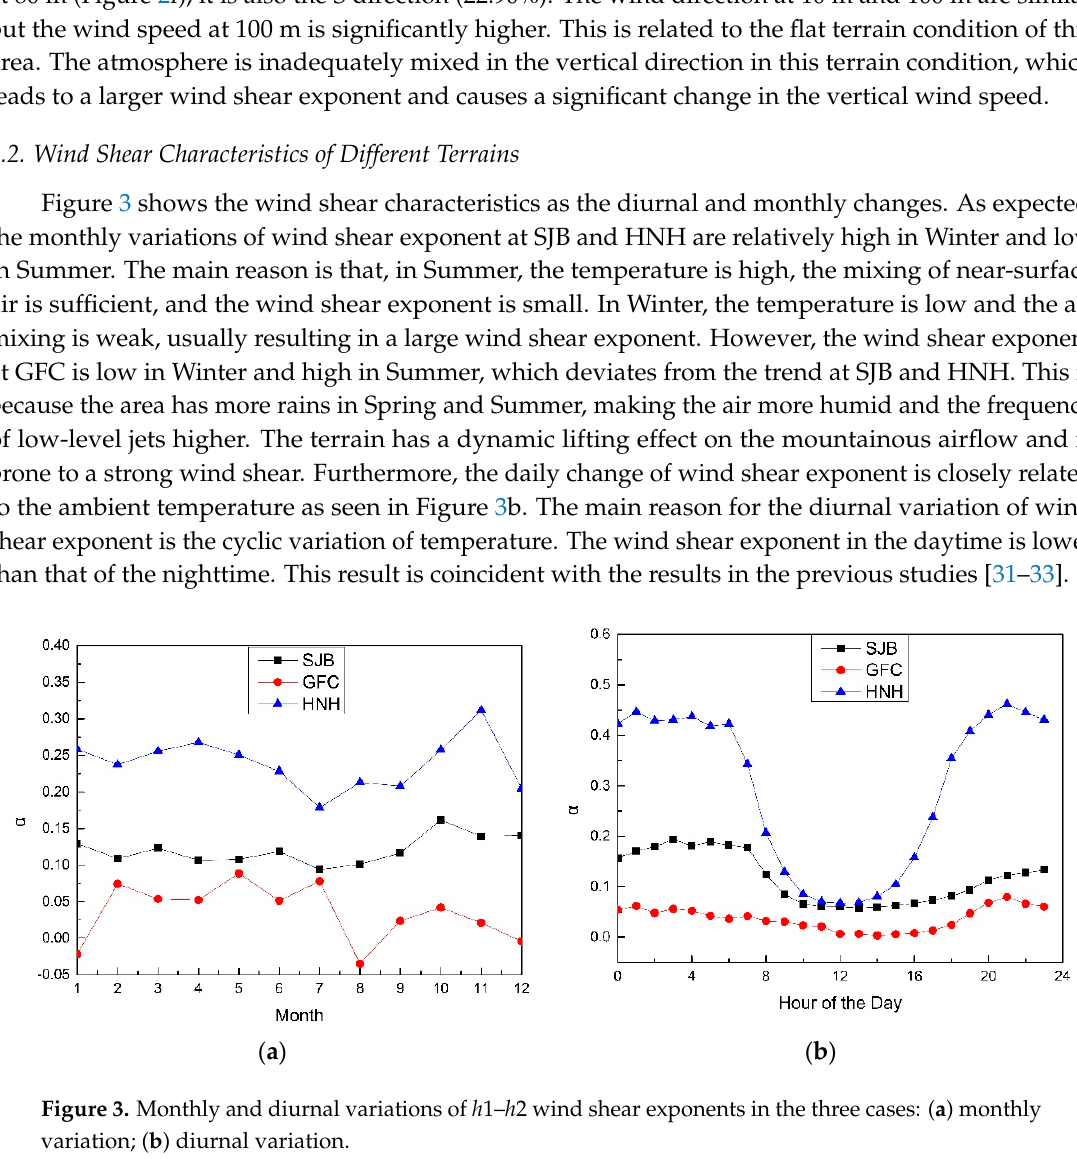
Figure 2. Wind rose measured at the three sites: ( a ) 30 m at SJB; ( b ) 70 m at SJB; ( c ) 30 m at GFC; ( d ) 80 m at GFC; ( e ) 10 m at HNH; ( f ) 100 m at HNH.